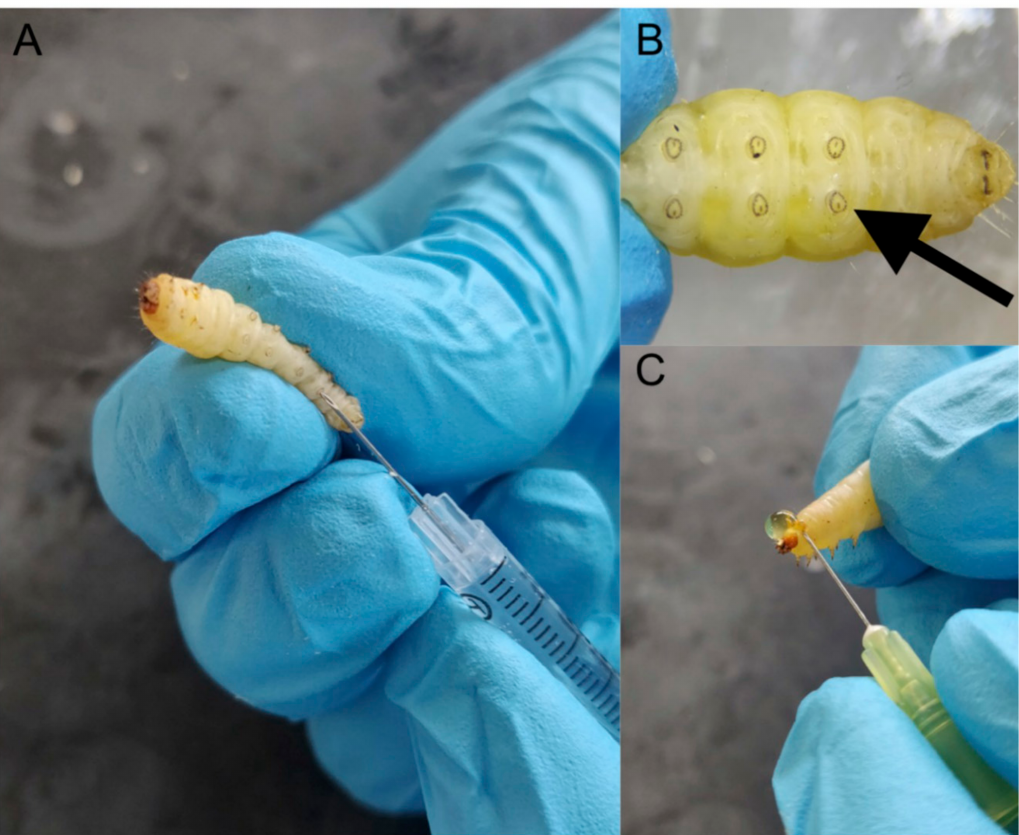
Figure 2. General procedures associated with using G. mellonella larvae. Larvae are inoculated with a specific volume (e.g., 20 µ L) through the last left proleg using a syringe ( A ), magnified image of last left proleg ( B ), demonstration of the method to obtain hemolymph from larvae ( C ).